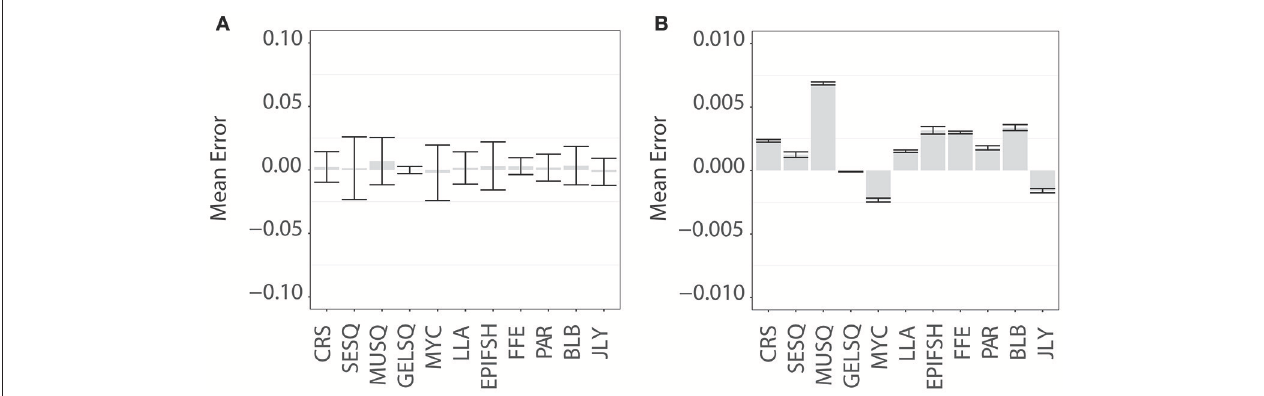
FIGURE 3 | QFASA modeling error for functional groups of prey. Bar plots represent the mean error (calculated as the difference between the QFASA-estimated diet and “true” pseudodiet diet fraction in prey functional groups displayed with (A) standard deviation and (B) 95% confidence intervals. Functional groups denoted by abbreviations: CRS, Crustacean; SESQ, Small Epipelagic Squid; MUSQ, Epi-Mesopelagic Muscular Squid; GELSQ, Bathy-Mesopelagic Squid; MYC, Mesopelagic Fish; LLA, Longline-Associated Prey; EPIFSH, Epipelagic Fish; FFE, Flying Fish Eggs; PAR, Ectoparasitic Copepod; BLB, Marine Mammal Blubber; JLY, Jellyfish.